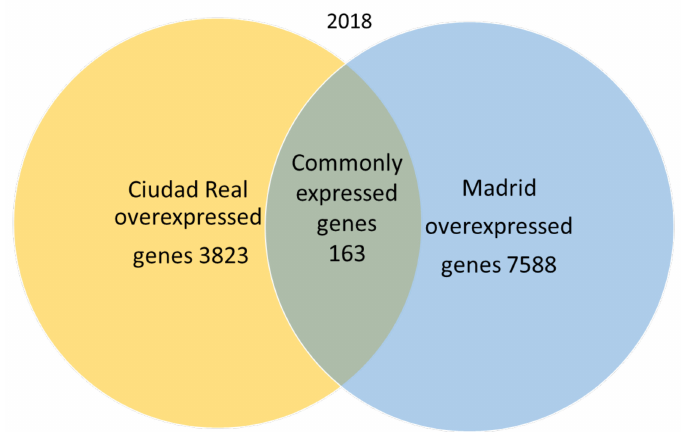
Figure 2. Venn diagram of overexpressed and common genes in the samples of pollen from Madrid and Ciudad Real in 2018 with a p adjust value <